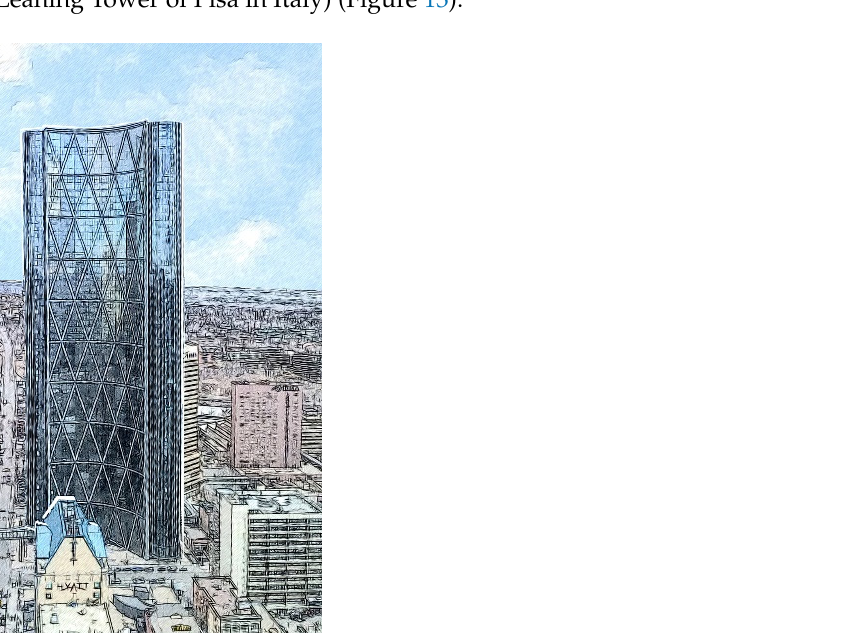
Figure 11. The Hearst Tower (2003) in New York City. (Photo by K. Al-Kodmany).